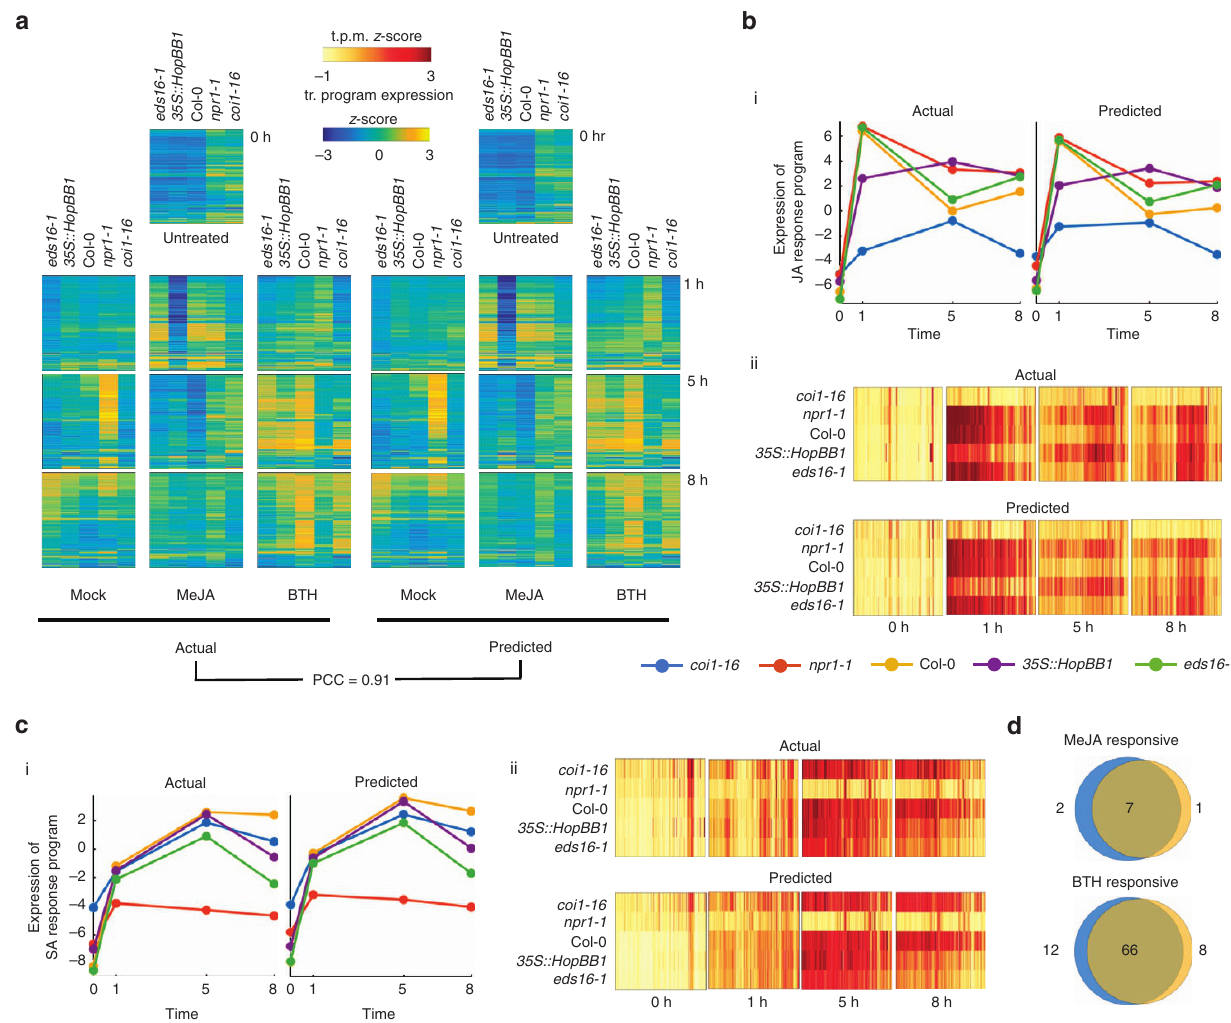
Figure 4 | Tradict accurately predicts transcriptional responses across time in response to hormone perturbation in an A. thaliana innate immune signaling data set. After being trained on the full A. thaliana training transcriptome collection, the selected set of 100 globally representative and context- independent markers were used to predict the expression of transcriptional programs and all genes for the transcriptomes presented in Yang et al. 31 . ( a ) Actual versus predicted heatmaps for the expression of all 150 transcriptional programs in A. thaliana across genotype, time and hormone treatment. ( b ) Predicted versus actual expression of (i) the JA response transcriptional program, and (ii) the genes involved in the JA response program. ( c ) (i–ii) Same as b , but for the SA response transcriptional program. ( d ) Hypothesis free, differential transcriptional program expression analysis as performed on the actual expression of transcriptional programs versus those predicted by Tradict. Blue circles represent the actual and orange represent the predicted. All heatmaps are clustered in the same order across time, treatment, genotype and between predicted and